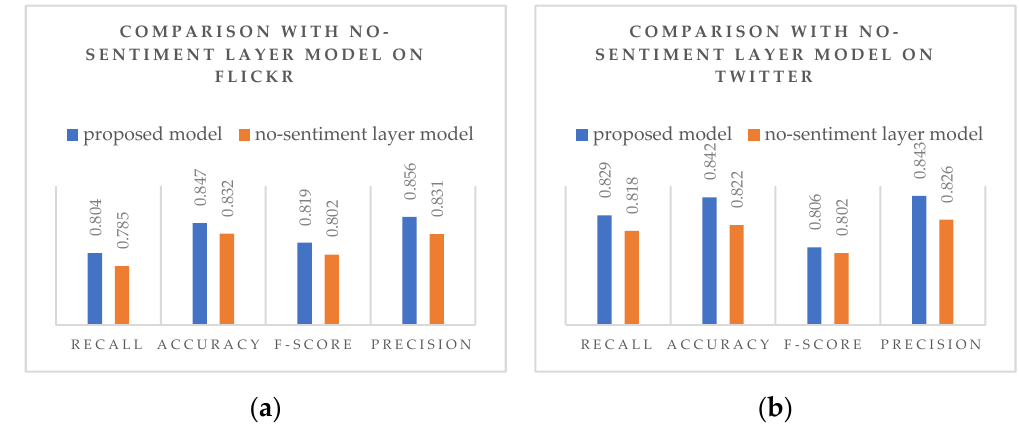
Figure 6. ( a ) Comparison experiment on Flickr; ( b ) comparison experiment on Twitter.